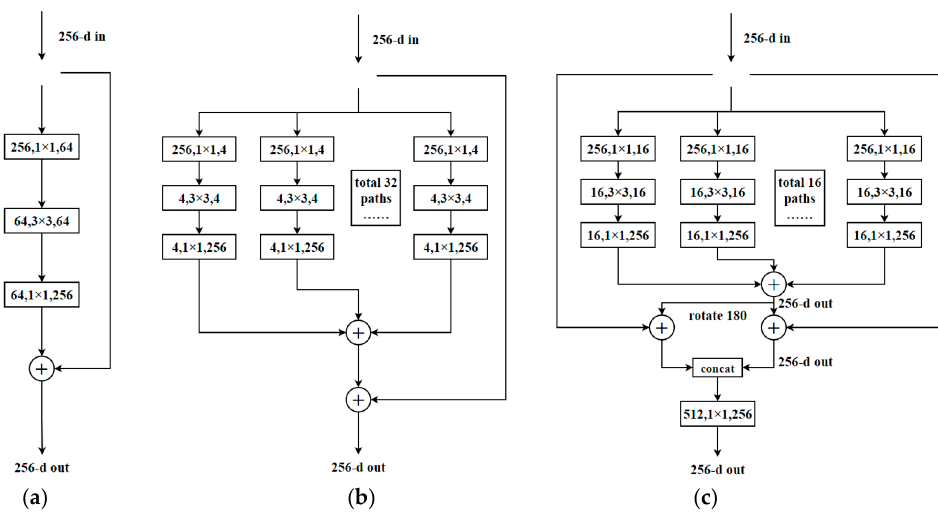
Figure 1. Evolution of convolution networks; ( a ) a block of ResNet; ( b ) a block of ResNeXt; ( c ) a block of ResNeXt-RC.